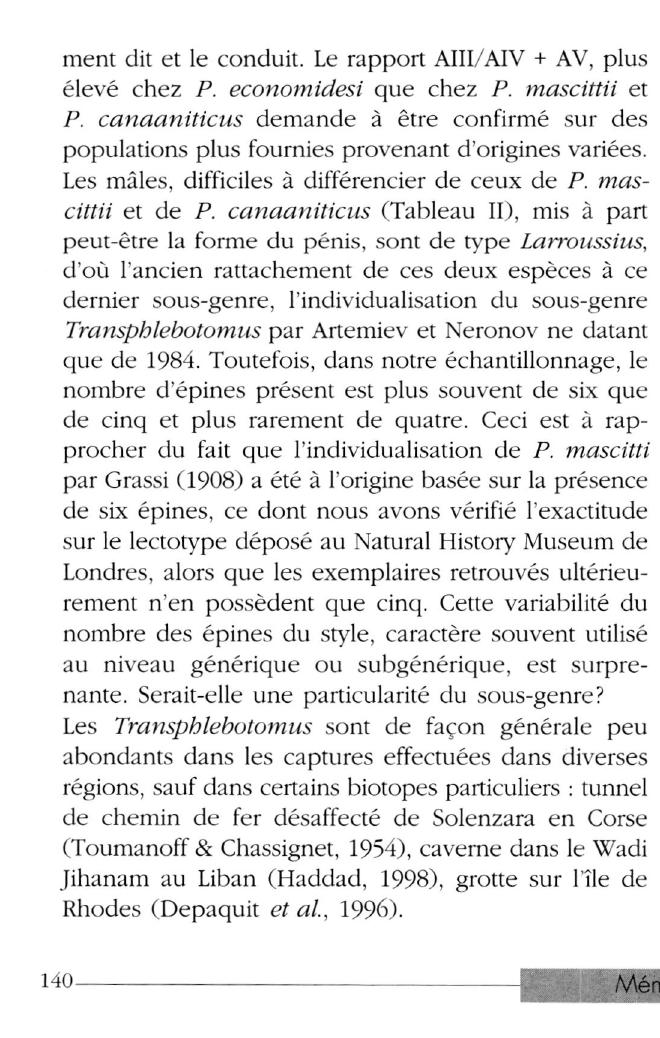
Fig. 5. - Distributions de P. canaaniticus (+), P. economidesi (G) et de P. mascittii